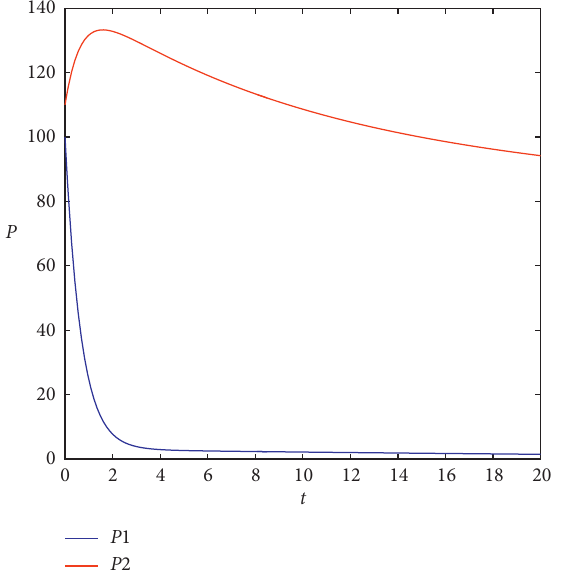
Figure 2: Pollution stock of the upstream P